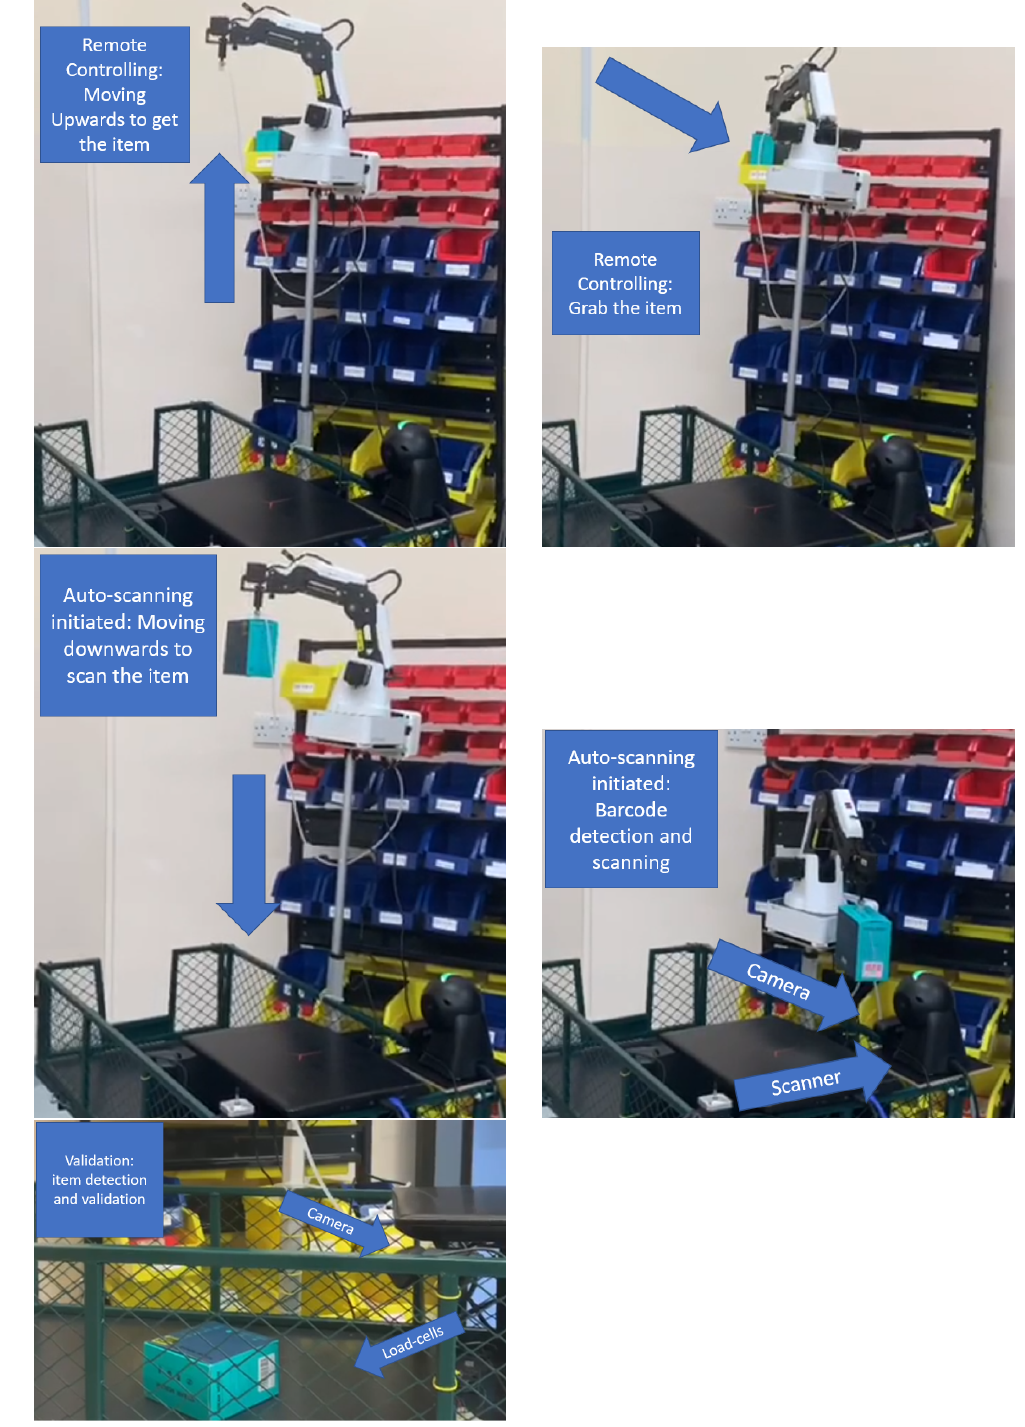
Figure 22. Stages of the proposed approach using